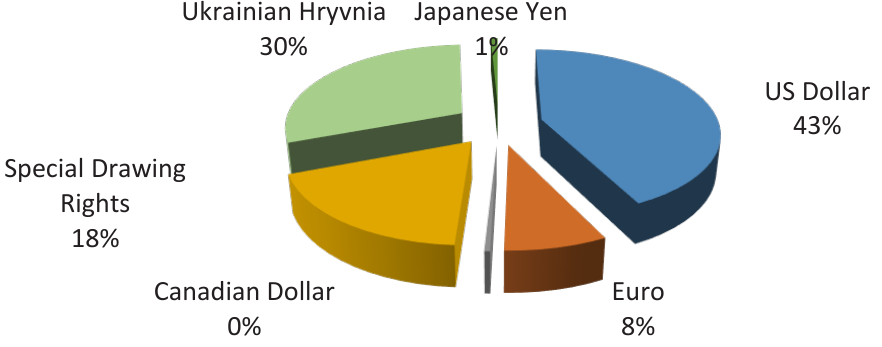
Figure 7. Currency structure of government and state guaranteed debt of Ukraine as of December 31,